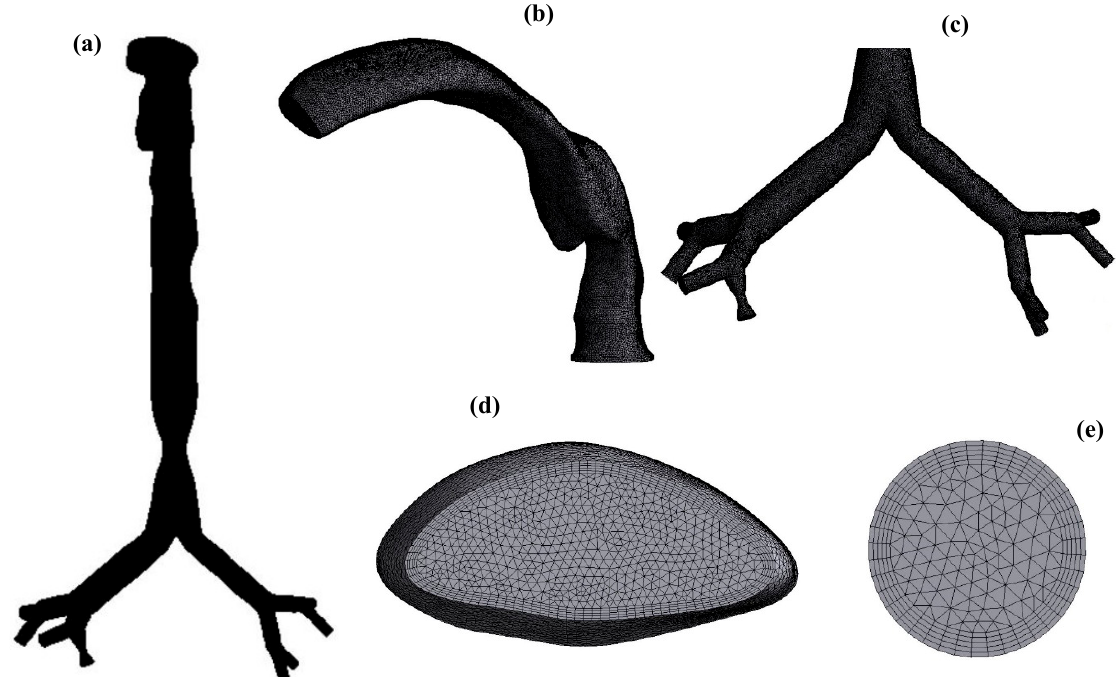
Figure 2. Unstructured mesh for selected sections of the lung model: ( a ) mesh for the whole lung model; ( b ) tetrahedral elements for the mouth–throat section; ( c ) mesh for a bifurcation branch; ( d ) inflation mesh at the inlet of the mouth–throat; and ( e ) inflation mesh at the outlet of the 3rd generation.